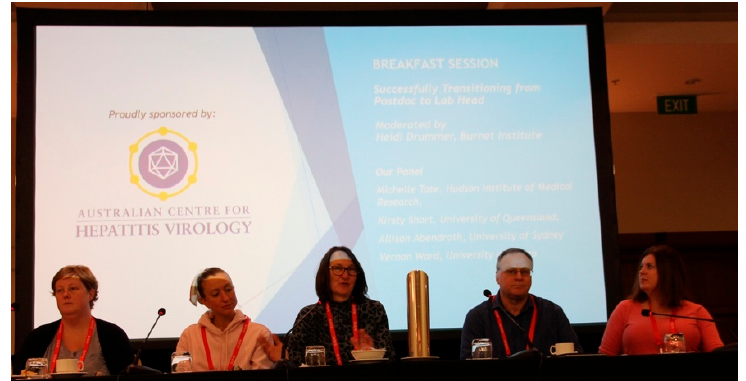
Figure 5. “Successfully transitioning from post-doc to lab head” career development session. Panel members from left to right: Dr. Michelle Tate, Dr. Kirsty Short, Professor Heidi Drummer (moderator), Professor Vernon Ward and Professor Allison Abendroth.